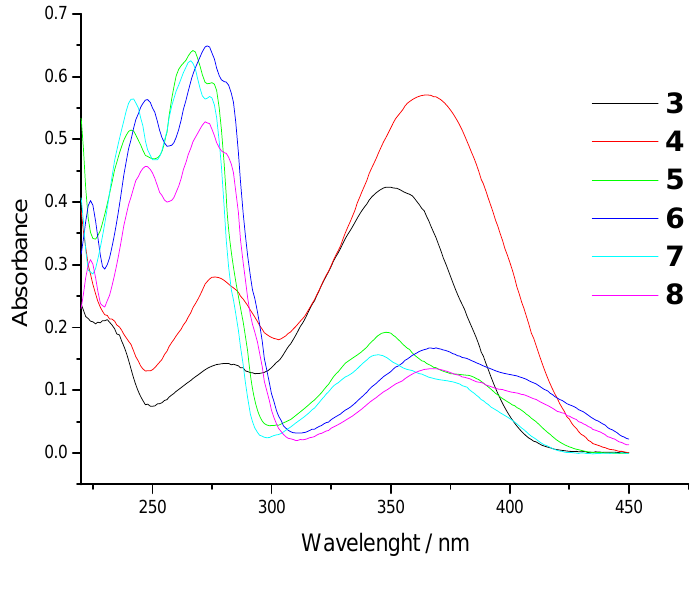
Figure 2. Fluorescence emission spectra of compounds 3-8 in EtOH, excited at λ